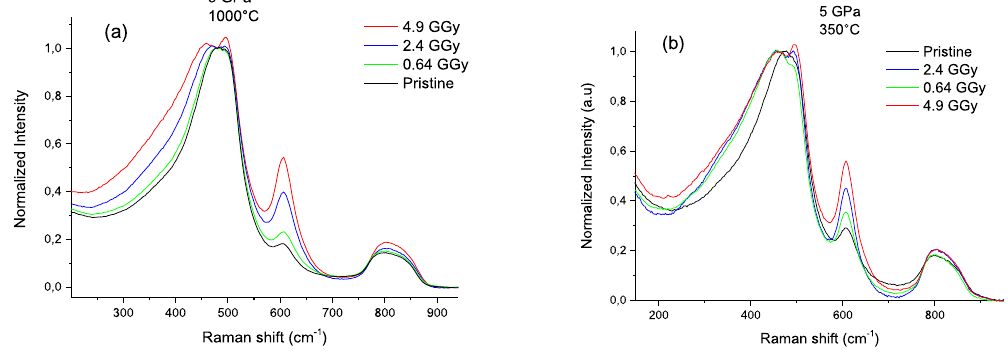
Figure 2. Raman spectra evolution with the integrated dose of (5 GPa, 1000 °C) ( a ) and (5 GPa, 350 °C) ( b ) samples.